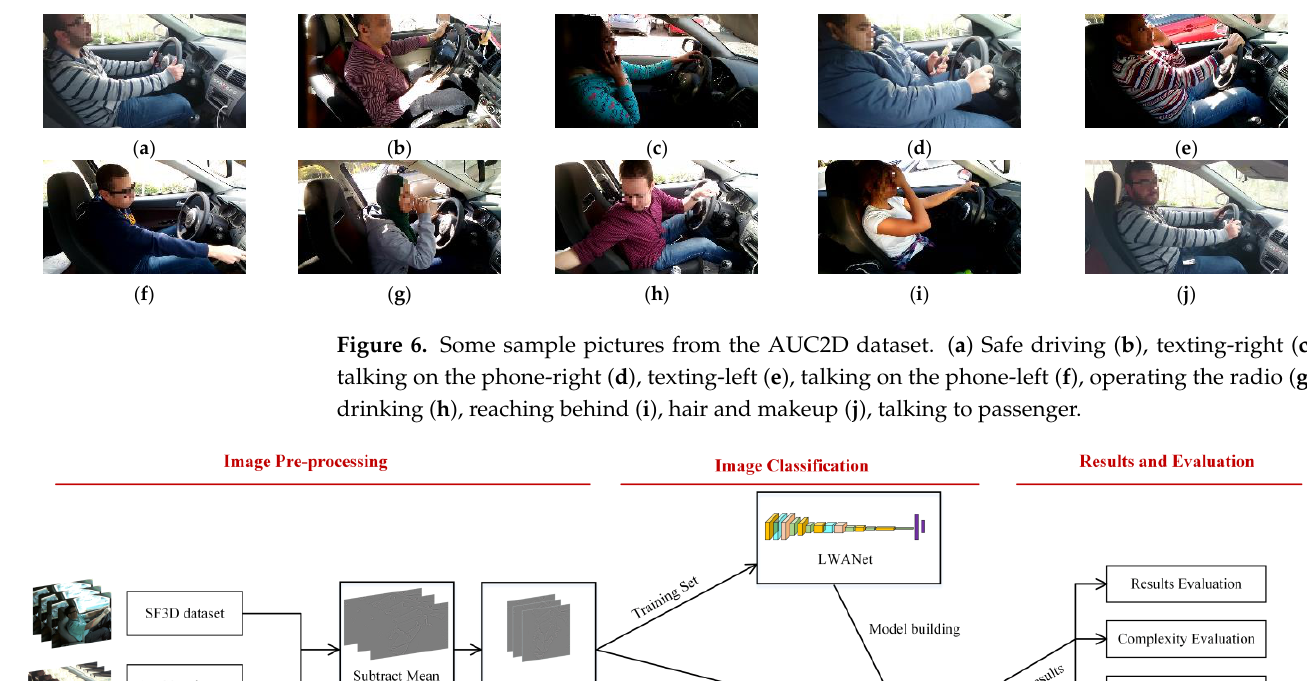
Figure 6. Some sample pictures from the AUC2D dataset. ( a ) Safe driving ( b ), texting-right ( c ), talk- ing on the phone-right ( d ), texting-left ( e ), talking on the phone-left ( f ), operating the radio ( g ), drinking ( h ), reaching behind ( i ), hair and makeup ( j ), talking to passenger.